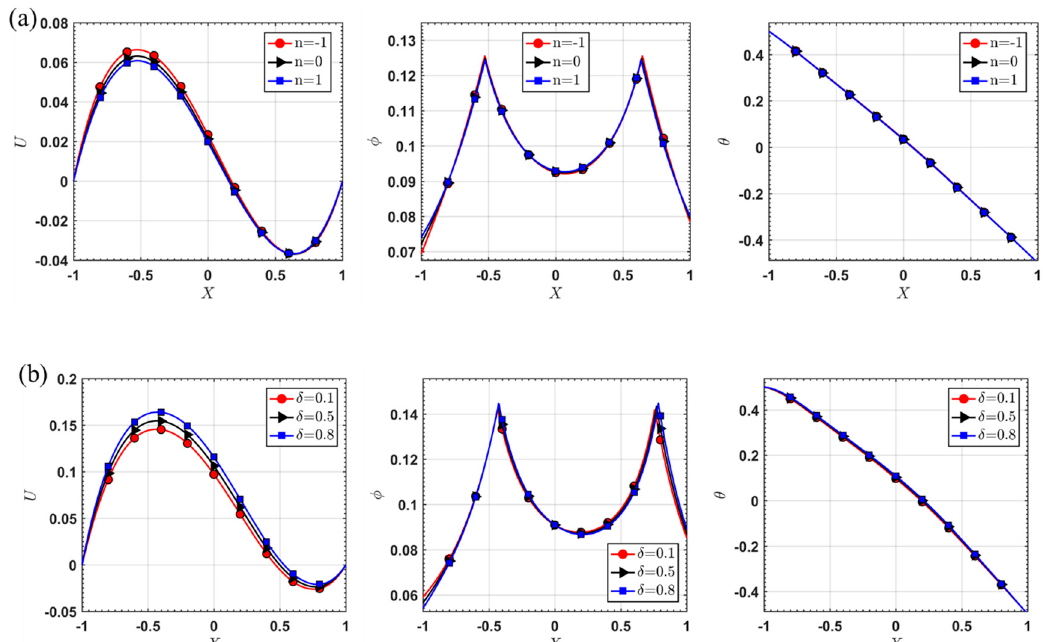
Figure 3. Parametric studies for shear-dependent viscosity. ( a ) E ff ect of n on the velocity, concentration and temperature profiles, when Γ c = 2.5, Γ µ = 0.1, Le = 10, δ = 1, Ra = 2, Br = 5 and φ avg = 0.1. ( b ) E ff ect of δ on the velocity, concentration and temperature profiles, when Γ c = 2.5, Γ µ = 0.1, Le = 10, n = − 0.5, Ra = 3, Br = 5 and φ avg = 0.1